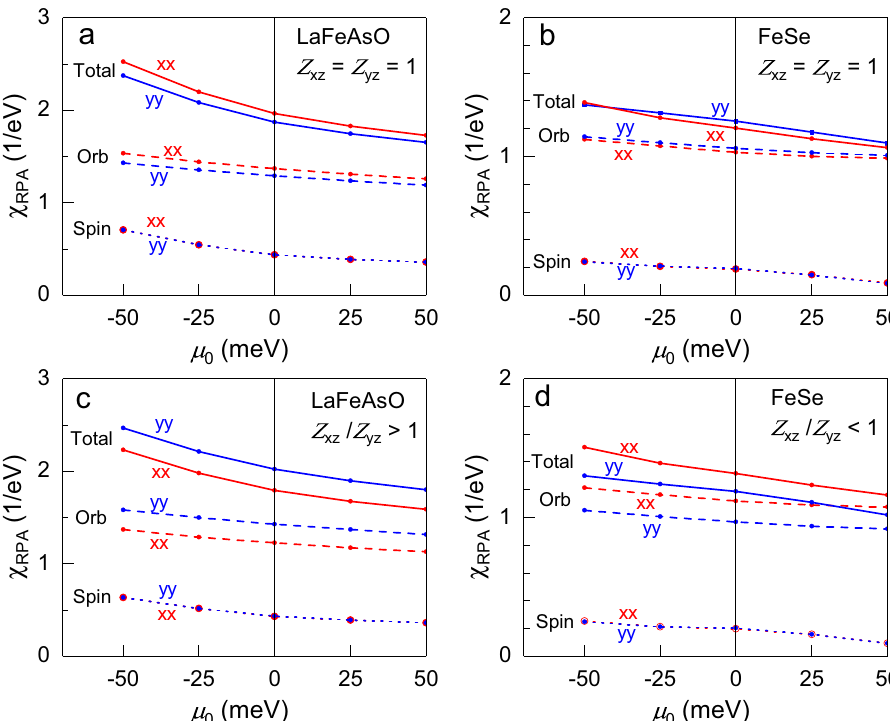
Fig. 3 Calculated magnetic susceptibility with and without self-energy effects. RPA susceptibilities ( U = 4 eV) for the static limit of the uniform susceptibility as a function of chemical potential μ 0 , for the band structures of LaFeAsO ( a , c ) and FeSe ( b , d ), respectively. Solid, dashed, and dotted lines refer to total, orbital, and spin contributions to the uniform susceptibility, respectively. Blue and red lines refer to χ χ xx (0, 0) and yy (0, 0), respectively. Panels ( a , b ) and ( c , d ) are obtained without [with] additional self-energy effects, as described in the main text. Exact values of the Z factors are given in Supplementary Note